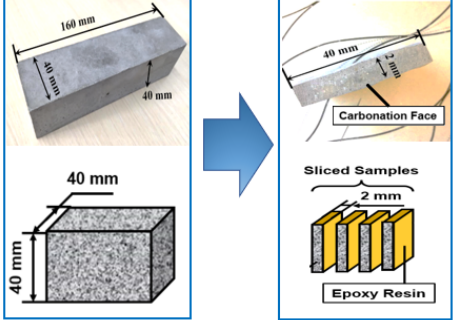
Figure 1. Schematic diagram for sample .